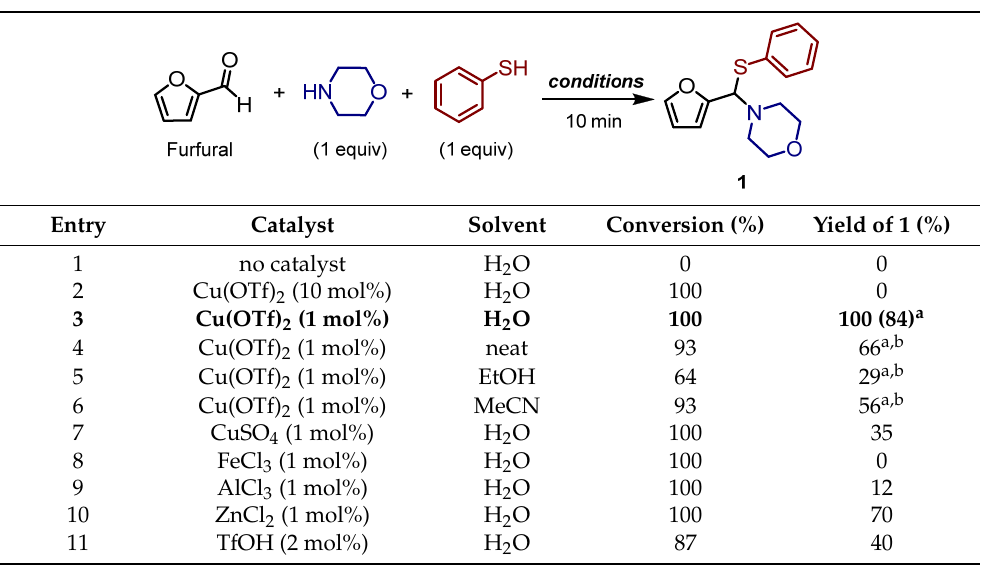
Table 1. Effect of Cu(OTf) 2 on the formation of thioaminals in aqueous media. a isolated yield. b Yield based on crude NMR.